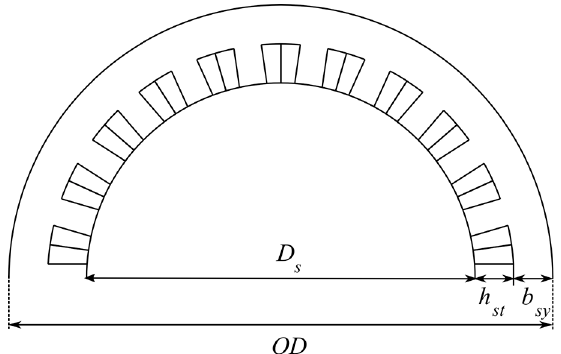
Figure 8. Stator 2D geometry and main quantities.